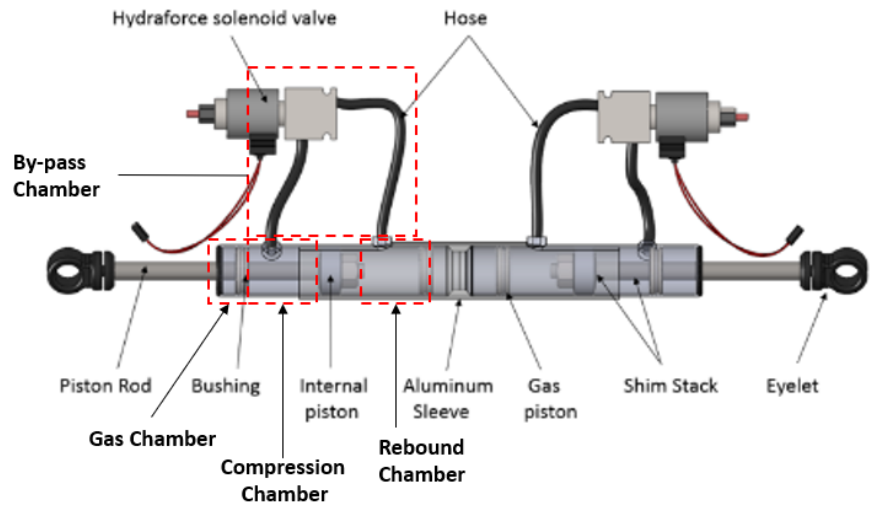
Figure 2. Construction of Double